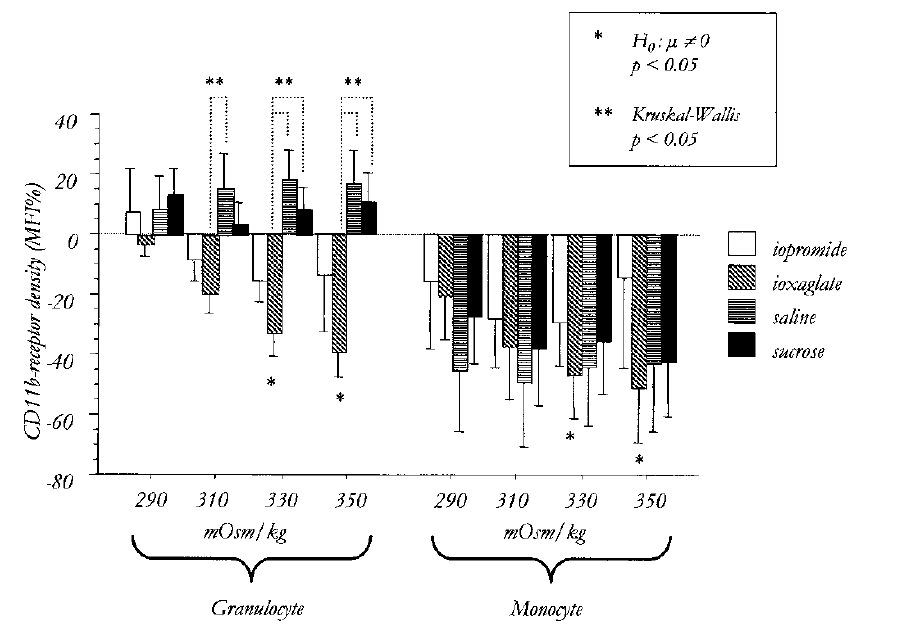
FIG. 3. ‘Invitro’ effect of osmolarity on CD11b expression. The effect of different solutions of iopromide, ioxaglate, sucrose and saline, with increasing osmolarity, on granulocytes and monocytes. * Statistical significant difference from zero (p B / 0.05). ** Significant statistical (p B / 0.05) ‘between group’ difference. CD11b-receptor density is expressed in% MFI, a value normalized for blank and maximal stimulation.